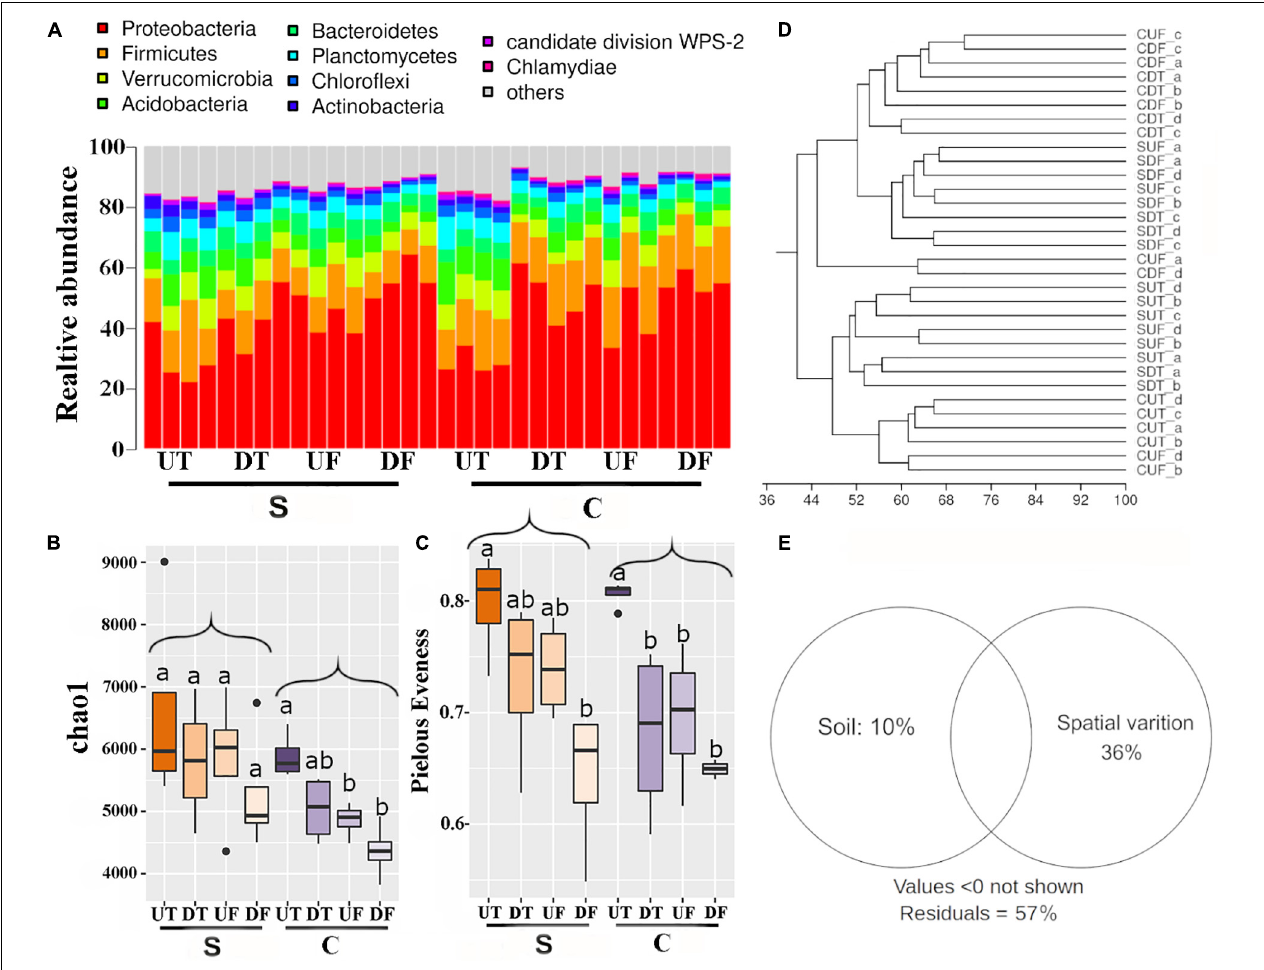
FIGURE 1 | Bacterial diversity in the rhizosphere of the upper (U) or lower (D) part of the taproot (T) or fibrous (F) roots treated by the disease-suppressive (S) or non-suppressive soil (C). Relative abundance of dominant phyla (A) , Chao1 richness (B) , Pielous’ evenness (C) , UPGMA cluster (D) , and variation explained by different soils or different parts of roots (E) . Significant differences in bacterial alpha-diversity among four parts of root under disease-suppressive or non-suppressive soil are indicated by different